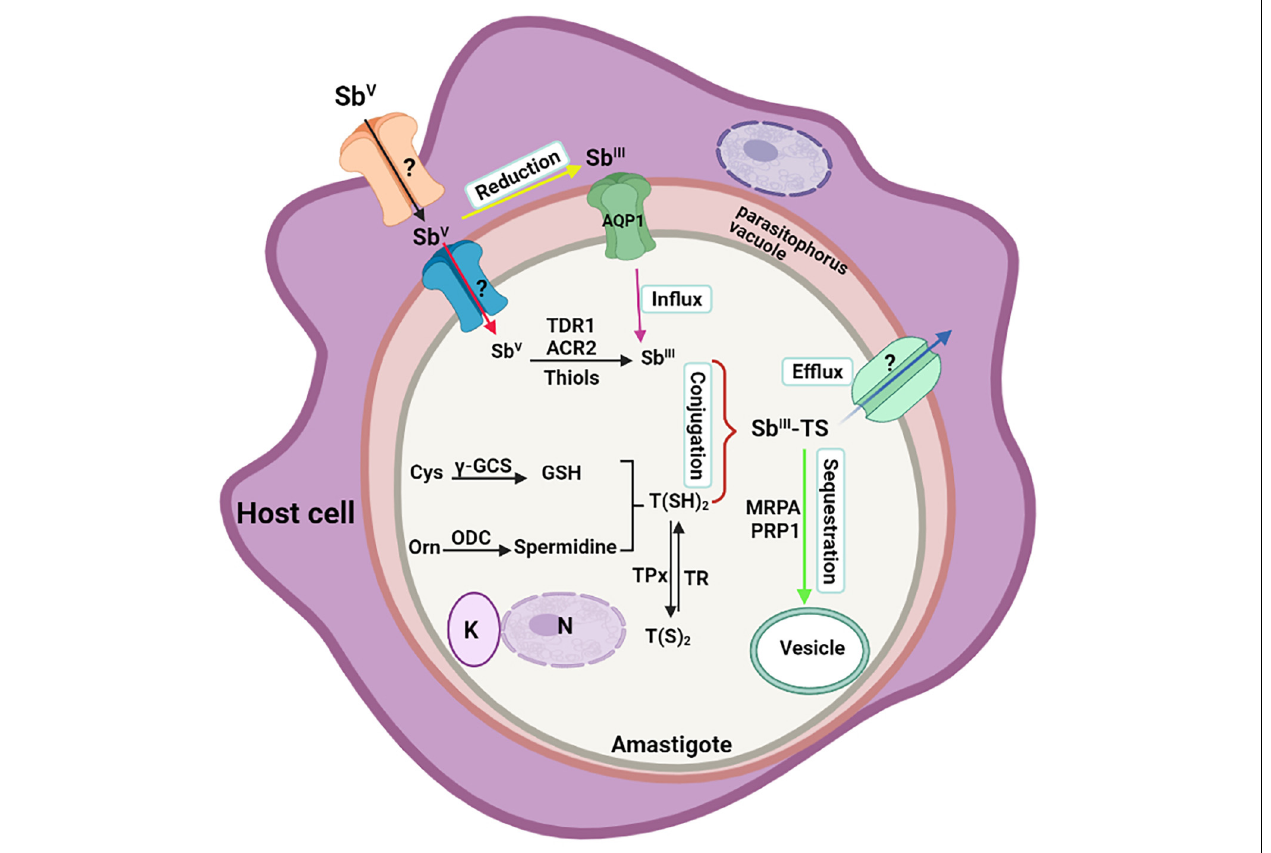
FIGURE 3 | Schematic diagram of molecular mechanisms involved in antimony resistance in Leishmania . The Figure illustrates a Leishman body inside a parasitophorous vacuole of the host macrophage. It represents the influx and reduction of antimonials to enter the parasite and other parasite mechanisms to reduce the effectiveness of the drug, causing the resistance form. AQP, aquaporin; MRPA, multidrug resistance protein A; TR, trypanothione reductase; γ -GCS, glutamylcysteine synthetase; TDR1, thiol-dependent reductase 1; ACR2, arsenate reductase 2; ODC, ornithine decarboxylase; TPx, thioredoxin peroxidase; PRP1, pentamidine resistance protein 1; N, nucleus; K,